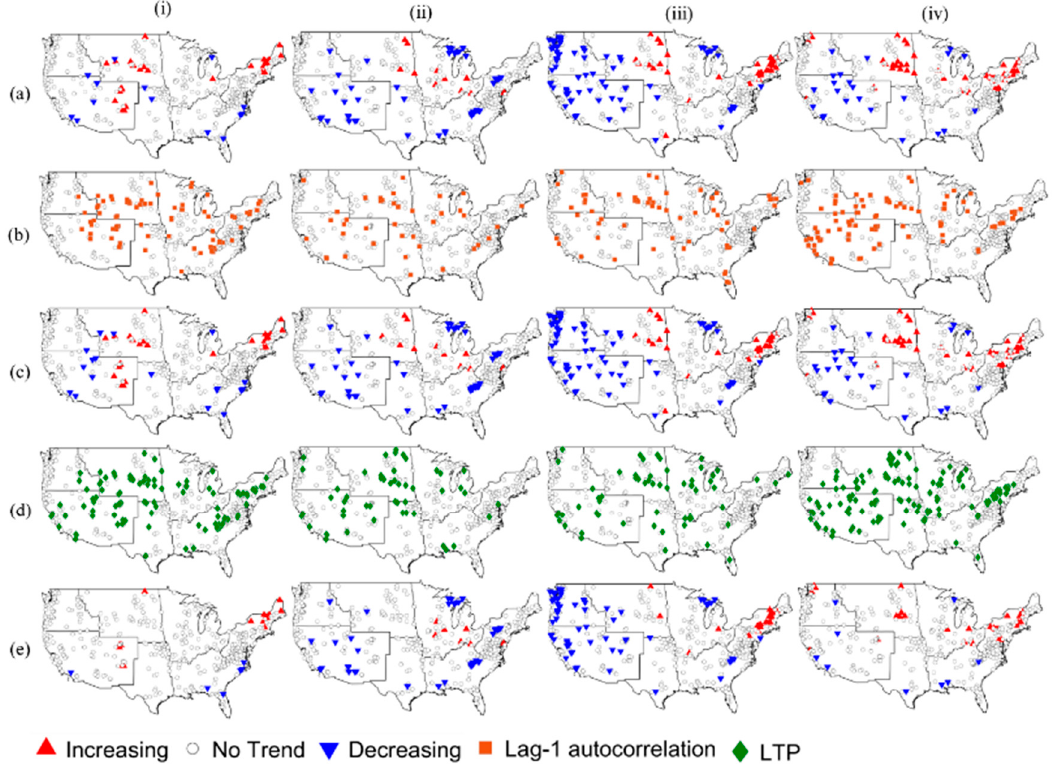
Figure 2. Maps showing results for trend, lag-1 autocorrelation, and long-term persistence (LTP) for ( i ) winter, ( ii ) spring, ( iii ) summer, and ( iv ) autumn streamflow volume. Row ( a – e ) summarizes MK1, Lag-1, MK2, LTP and MK3 results, respectively. All the stations showing (increasing / decreasing) the trend at the statistical significance of p ≤ 0.05 are represented by the (upward / downward) triangles. Squares and diamonds represent the station showing lag-1 autocorrelation and LTP. Circles represent the absence of a trend, lag-1 autocorrelation and LTP.